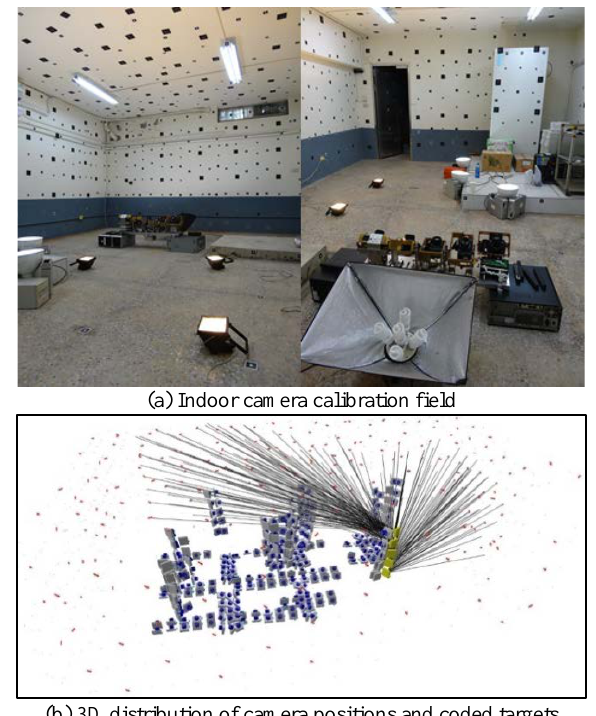
Figure 7. Camera calibration